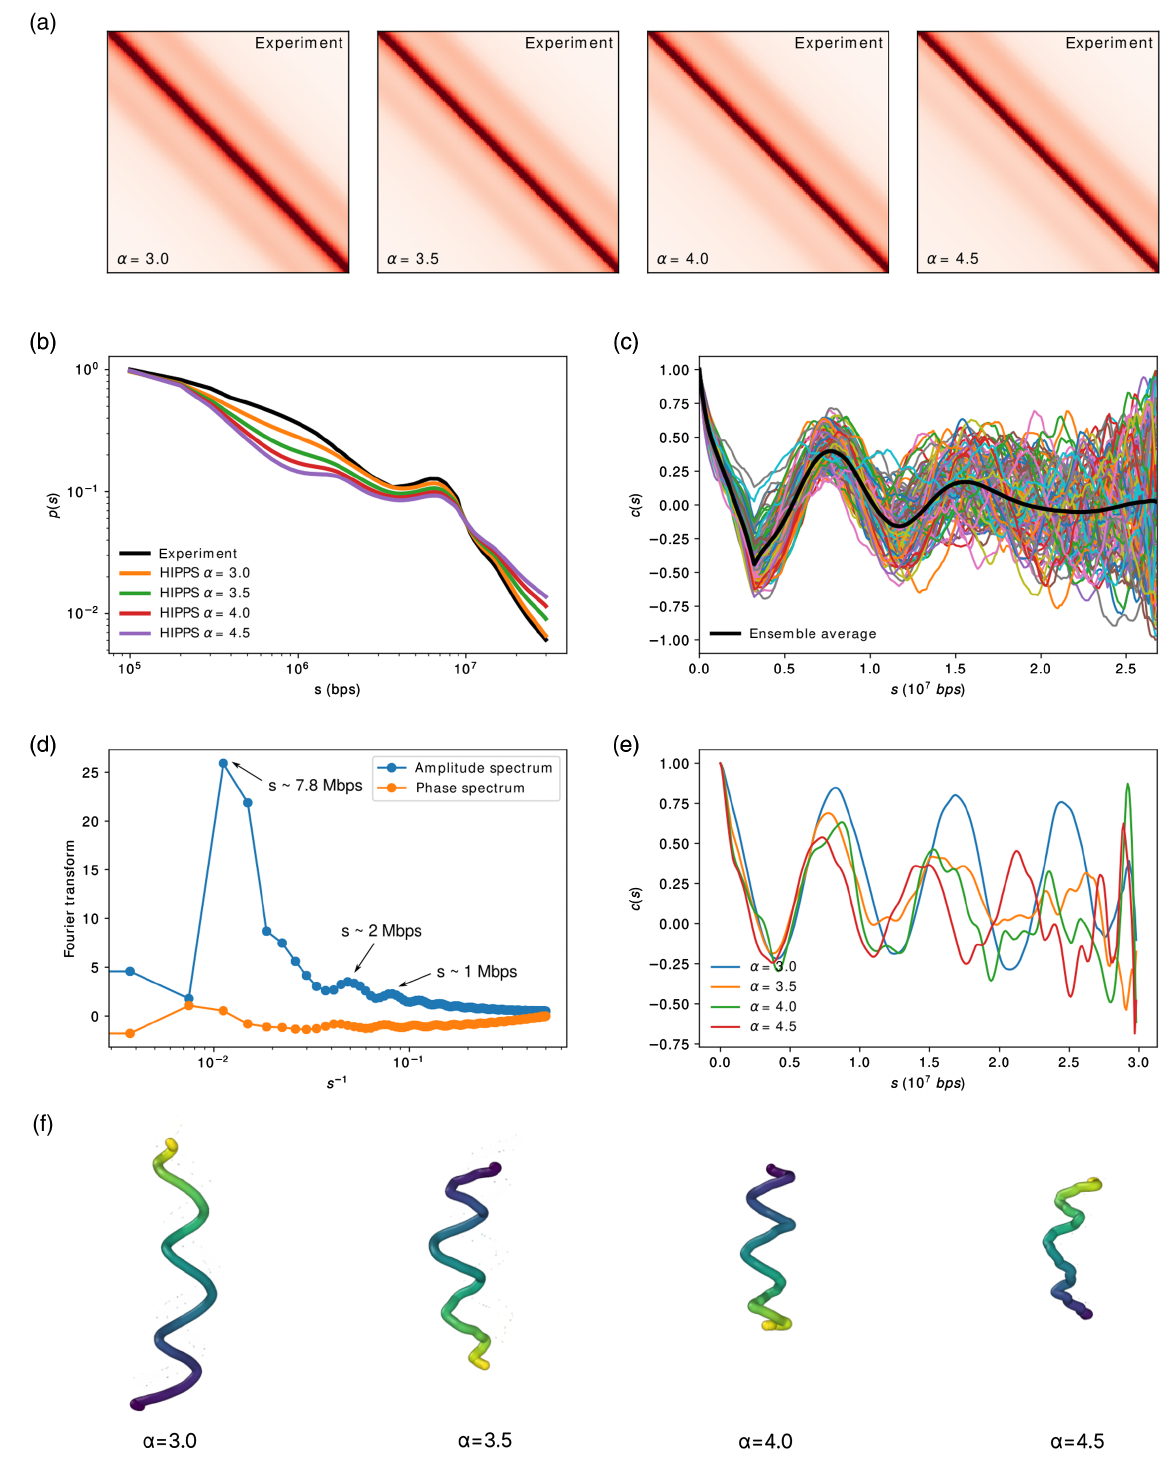
FIG. 9. (a) Comparison between the theoretical Hi-C CM (described in the text) and the simulated CM for α ¼ 3 . 0 , 3.5, 4.0, 4.5. (b) Experimental and simulated contact probability profiles P ð s Þ for different values of α for chicken mitotic chromosomes. (c) Angle correlation function c ð s ; d Þ for individual structures and the average curve h c ð s ; d Þi (black curve). The value of d is 32. (d) Fourier transform of average c ð s ; d Þ . Three peaks are marked with corresponding length scales in terms of number base pairs. (e) Angle correlation function c ð s ; d Þ with d ¼ 32 computed from the average structures shown in (f). (f) The averaged structure for α ¼ 3 . 0 , 3.5, 4.0, 4.5. A total number of 100 000 random independent individual structures are used to compute the average